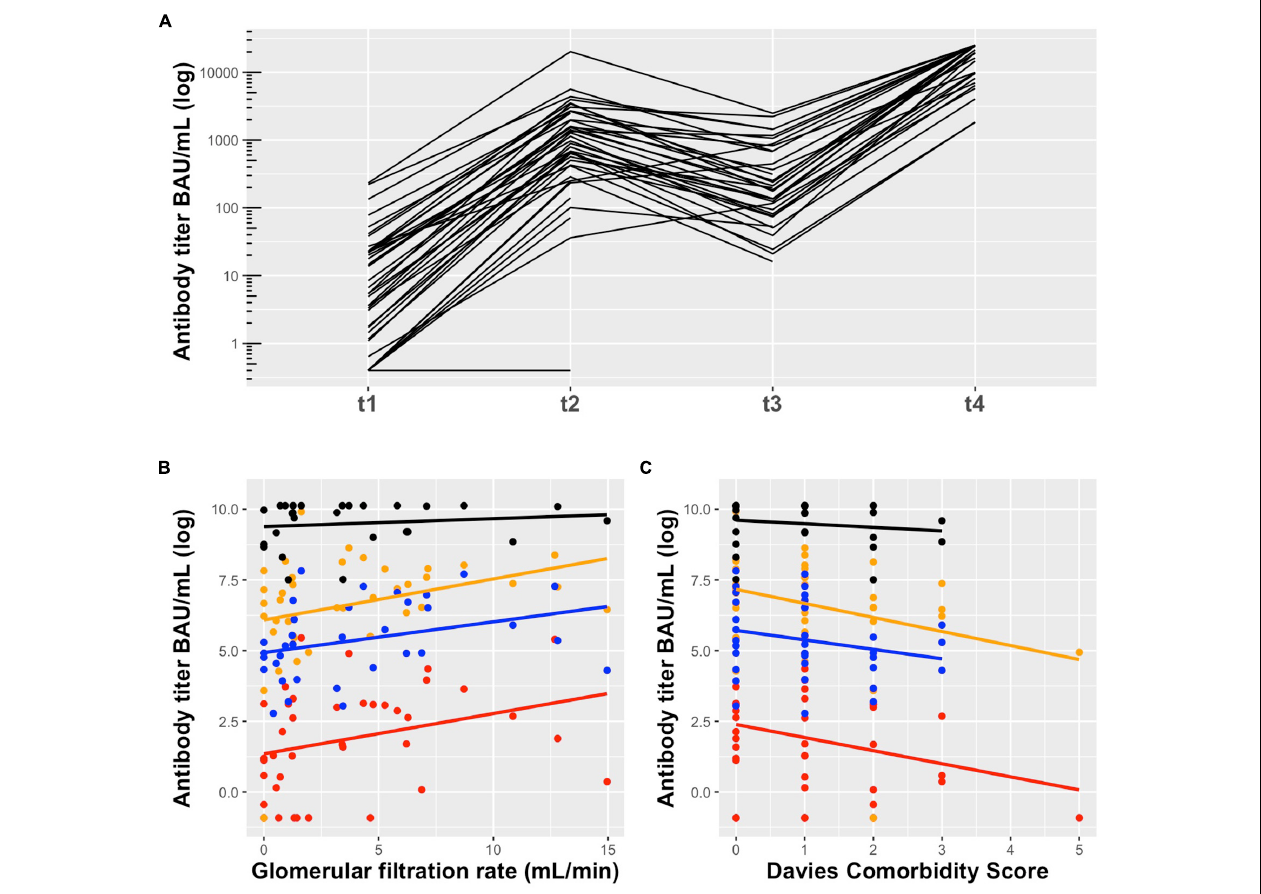
FIGURE 2 | (A) Anti-SARS-CoV-2 S antibody levels in peritoneal dialysis patients in response to mRNA-1273 vaccine: t1 = 1 month after the first dose (median = 6.62 BAU/mL, IQR 1.57–22.50), t2 = 1 month after the second dose (median = 968 BAU/mL, IQR 422.50–2244.5), t3 = 6 months after the second dose (median = 192 BAU/mL, IQR 84.5–685.0), and t4 = 1 month after the third dose (median = 19,405 BAU/mL, IQR 8,884–25,000). Six months after the second dose antibodies substantially declined and increased significantly after the third dose of mRNA-1273 vaccine. The technical lower and upper limit of detection were 0.4 BAU/mL and 25,000 BAU/mL, respectively. (B) Association of GFR and (C) Davies Comorbidity Score with anti-SARS-CoV-2 S antibody titers in peritoneal dialysis patients in response to mRNA-1273 vaccine 1 month after the first dose (red), 1 month after the second dose (orange), 6 months after the second dose (blue) and 1 month after the third dose (black). A higher GFR and lower Davies comorbidity score are associated with higher antibody titers. This association was particularly evident after the first and second dose, but almost disappeared after the third dose.